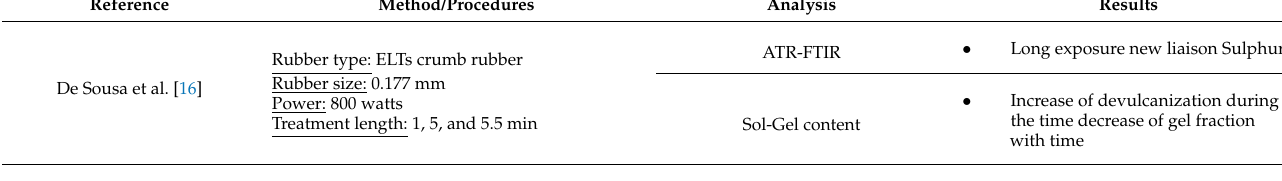
Table 3. Summary of studies on the procedures and results using microwaves treatment. Reference Method/Procedures